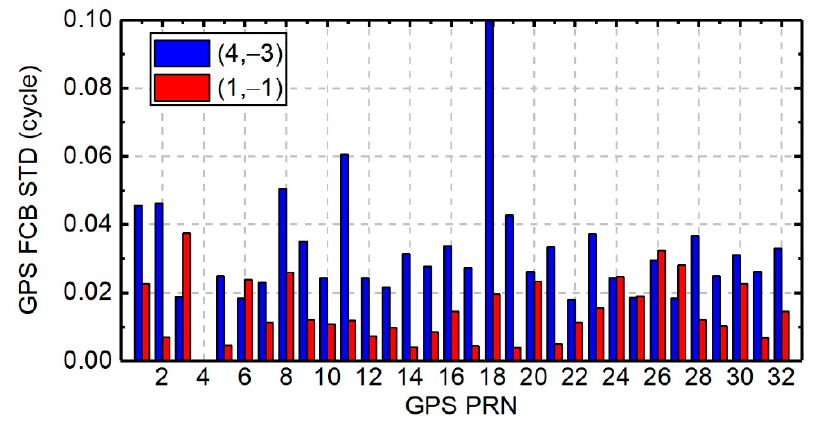
Figure 9. STD of the one day (3 September 2019) GPS FCB time series for each satellite NL and WL combination.